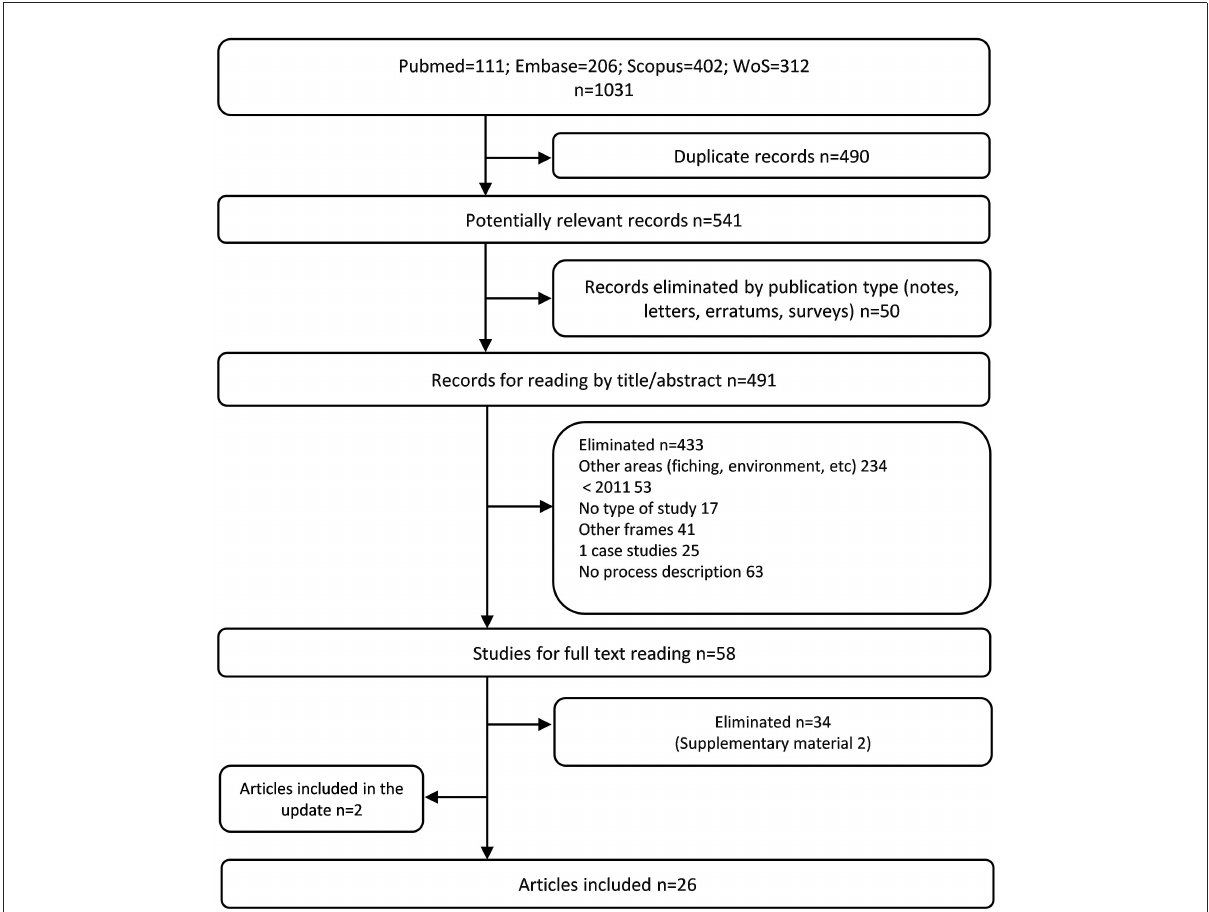
FIGURE1 Preferred reporting item for systematic reviews and meta analyses (PRISMA) flow diagram of the study selection process.